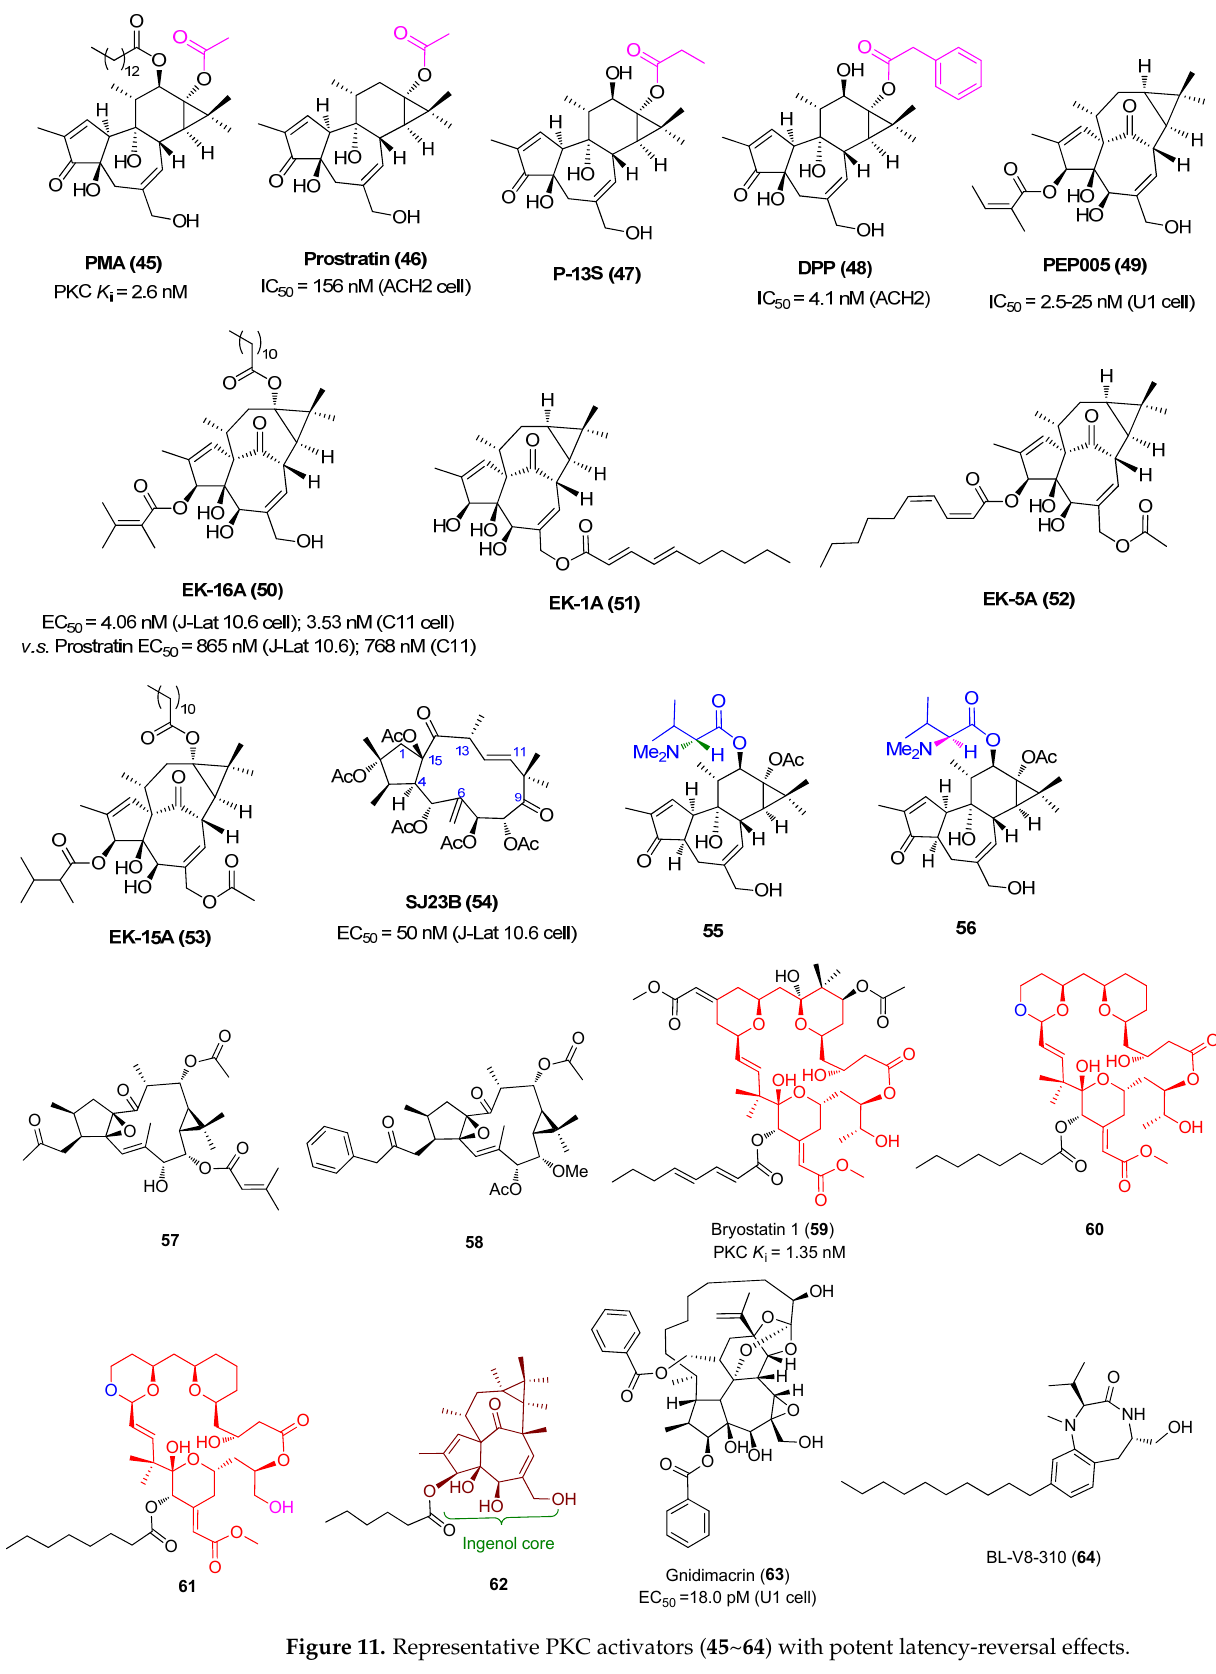
Figure 11. Representative PKC activators (45~64) with potent latency-reversal effects.